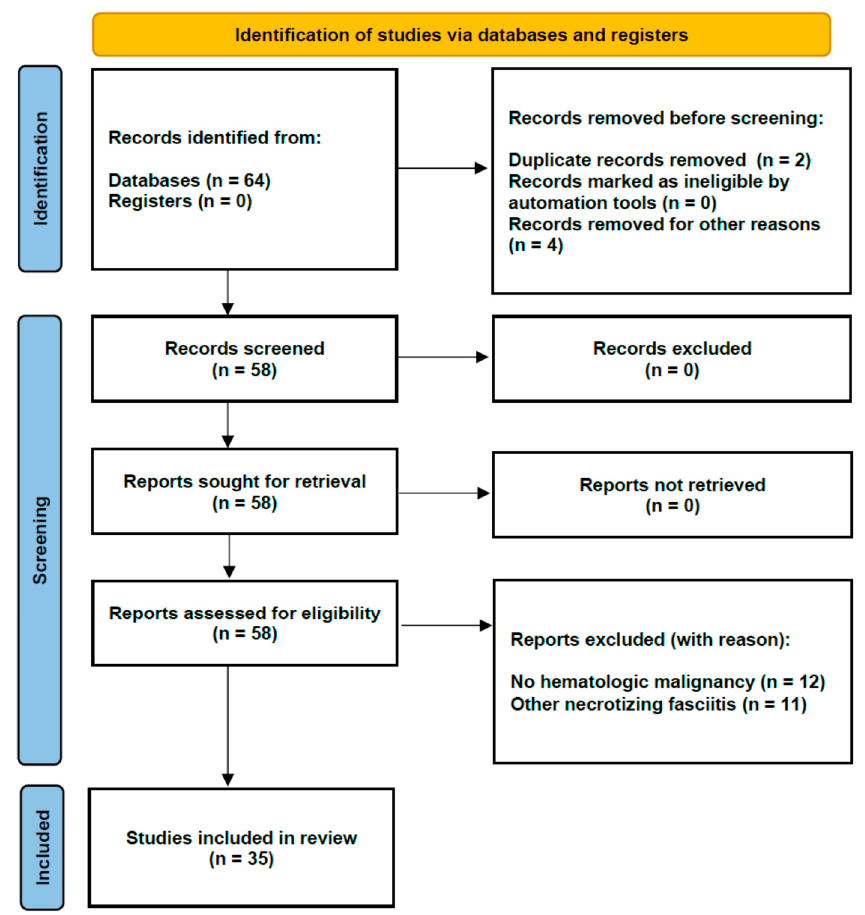
Figure 1. Flow diagram of the systematic review.